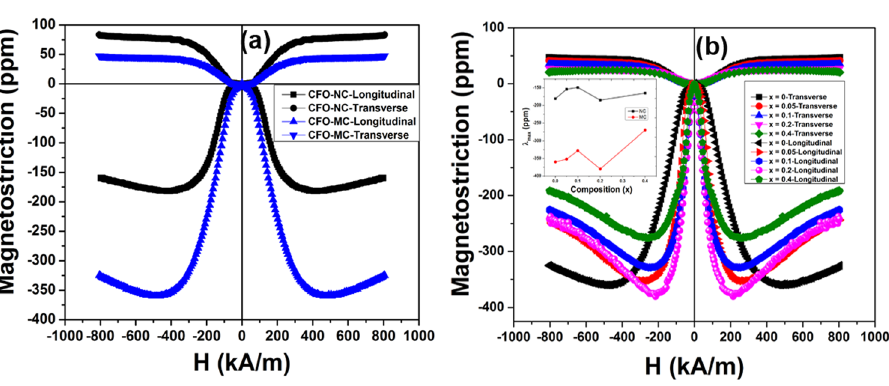
Figure 6. Longitudinal and Transverse magnetostriction curves of ( a ) CFO - NC and MC ( b )